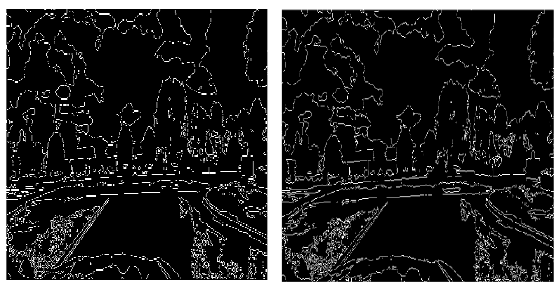
Figure 3. Raw image from training